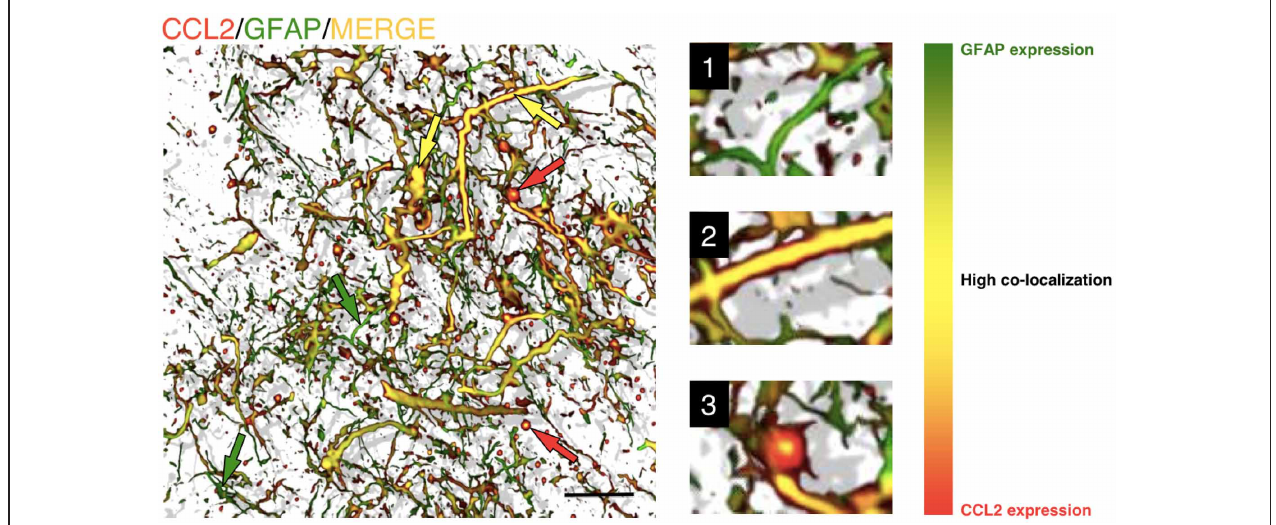
FIGURE 3 | Astrocytes in GBM are able to adopt various shapes and differentially express chemokines. Three-dimensional reconstruction, rendered from confocal images, of GFAP/CCL2 + astrocytes within a human brain tumor section (biopsy from glioblastoma). It is not possible to distinguish tumorigenic astrocytes from resident astrocytes, but cells adopt different shapes in the neoplastic areas, ranging from star-shaped cells to elongated cell bodies with thick and long filaments. The level of co-localization between GFAP and CCL2 can be observed as a color gradient. This gradient is shown in the scale on the right. Smaller GFAP + cells and thinner filaments